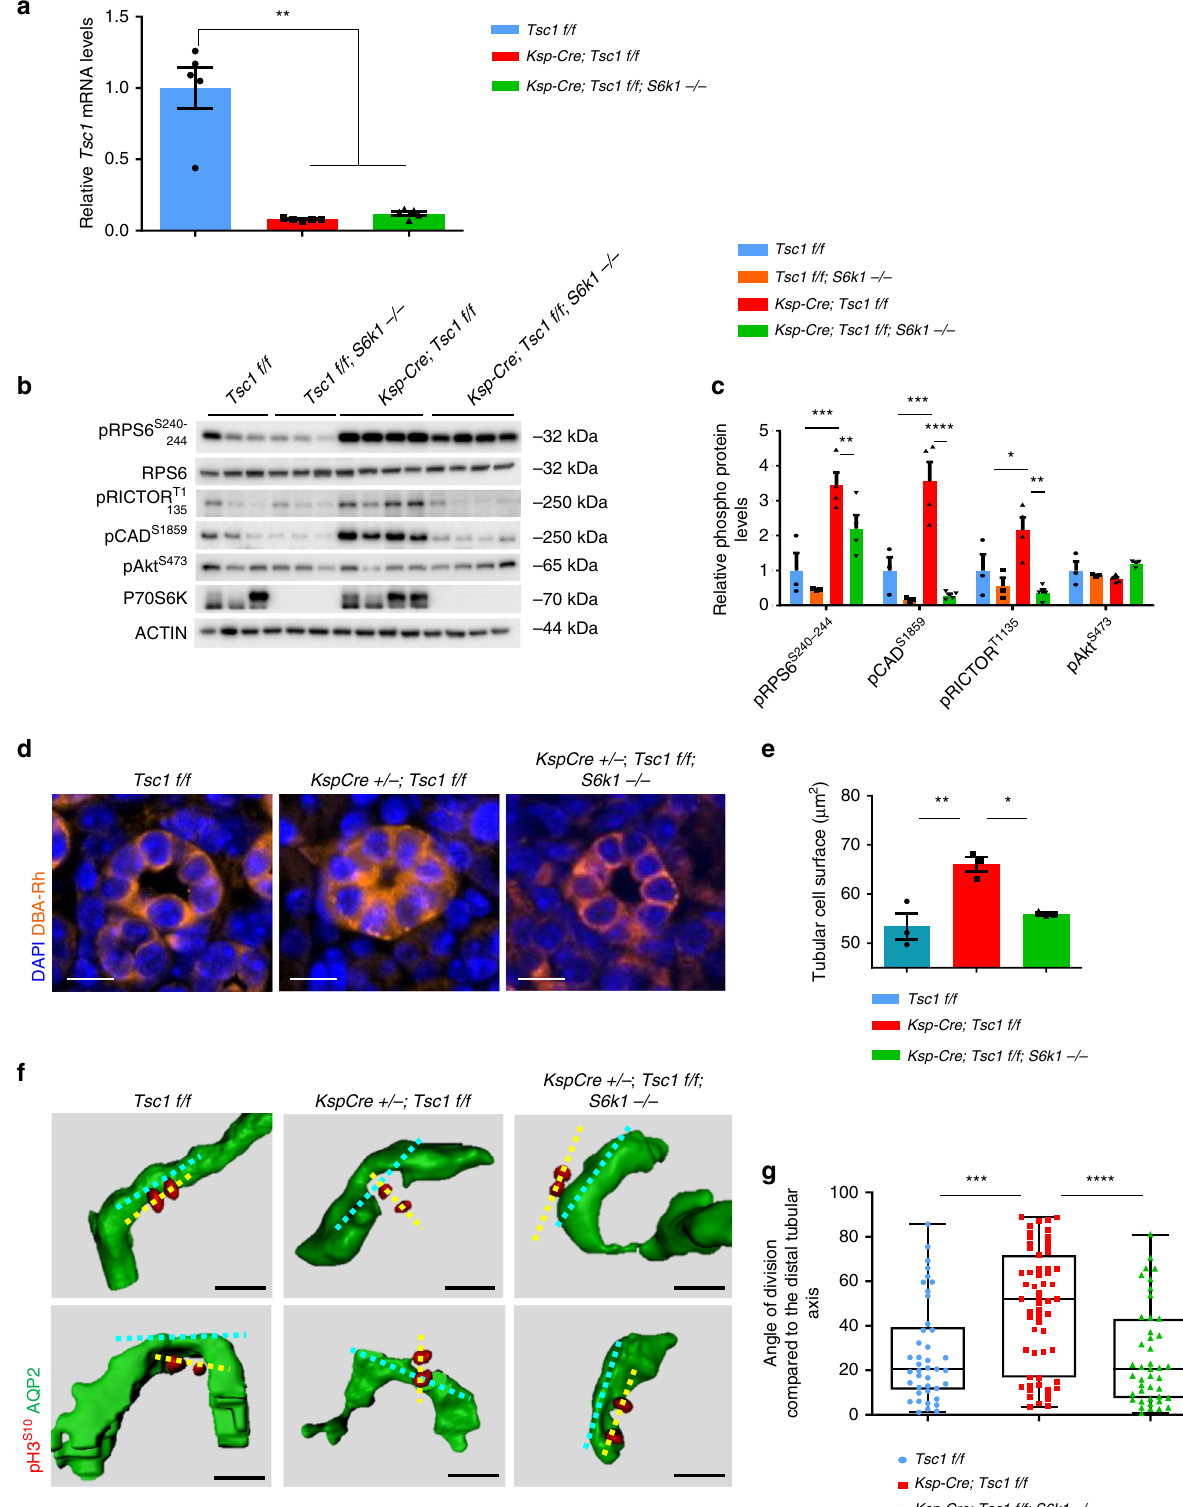
mTORC1/S6K1 activation and cell size alterations preceded cyst formation in mouse TSC kidneys. Loss of S6k1 rescues mis-oriented cell division in a TSC background . The control of cell division orientation